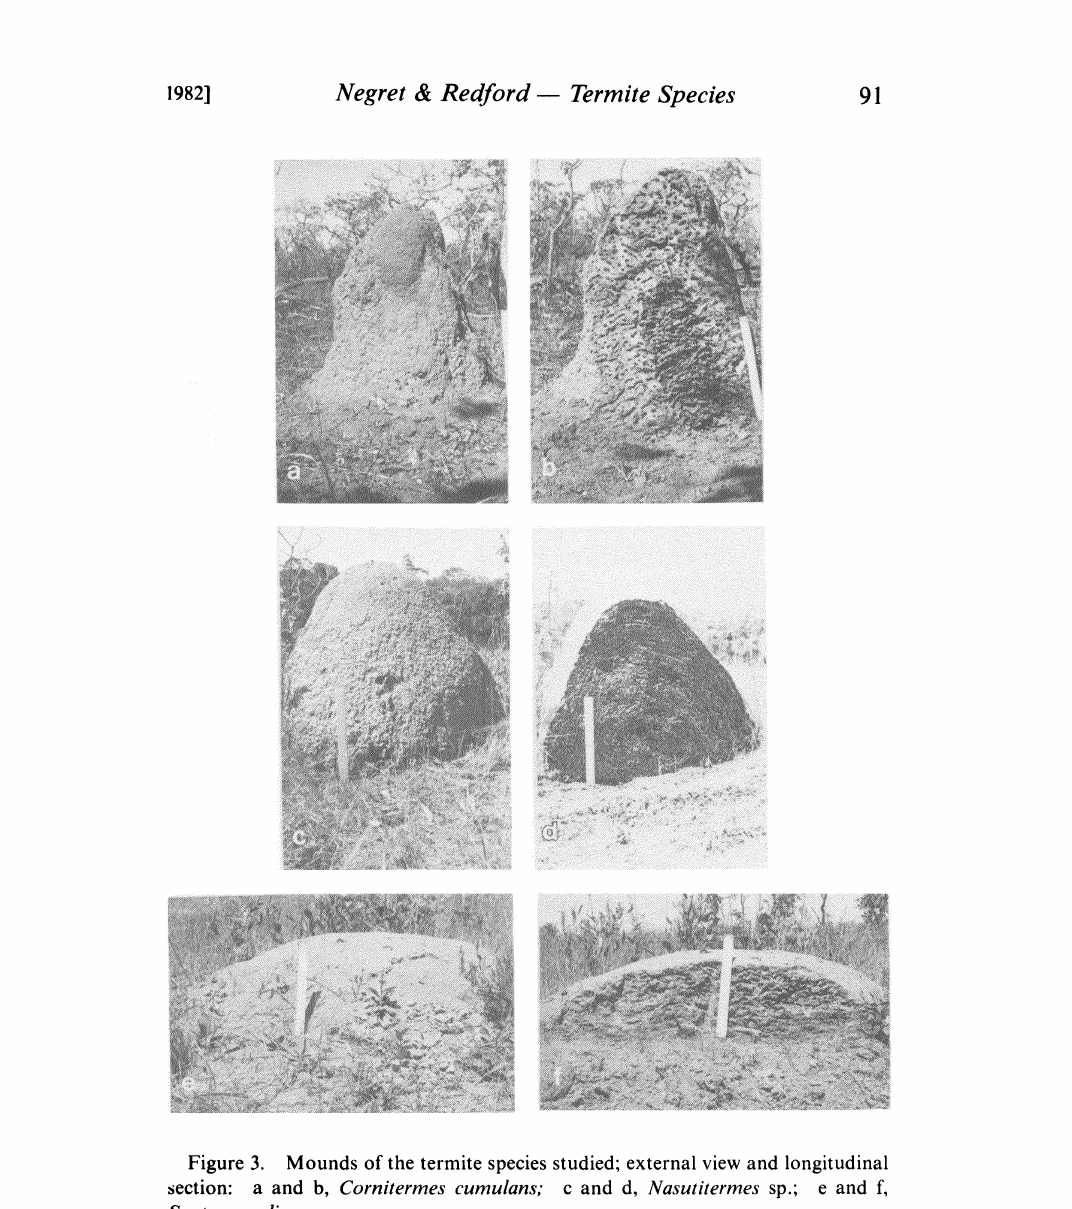
Figure 3. Mounds of the termite species studied; external view and longitudinal section: a and b, Cornitermes cumulans; c and d, Nasutitermes sp.; e and f, Syntermes